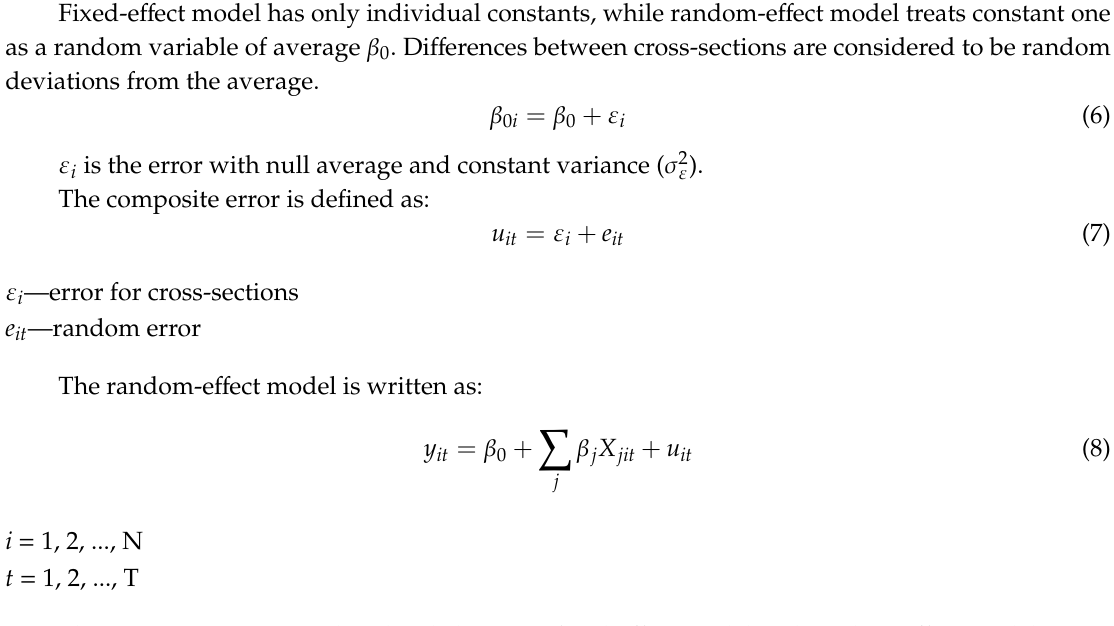
ESS POLS —sum of square errors in case of pooled ordinary least squares model ESS FE —sum of square errors in case of fixed-e ff ect model